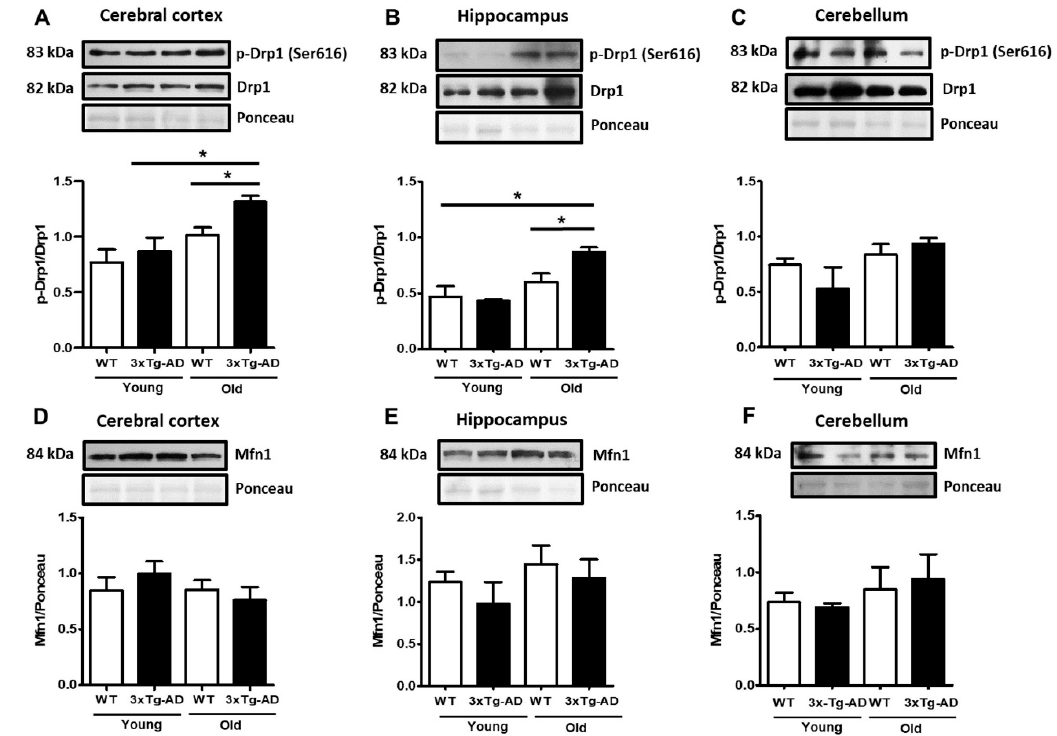
Figure 3. Changes in mitochondrial fission and fusion proteins. Representative Western blot and densitometric analysis of Drp1 and p-Drp1 in cortical ( A ), hippocampal ( B ), and cerebellar synaptosomes ( C ). The contents of Mfn1 in cortical ( D ), hippocampal ( E ), and cerebellar ( F ) samples are shown. Bars represent the densitometric analysis of proteins normalized to Drp1 or Ponceau expression and represent the mean ± SEM of 3–4 independent experiments. Student’s t test * p < 0.05.